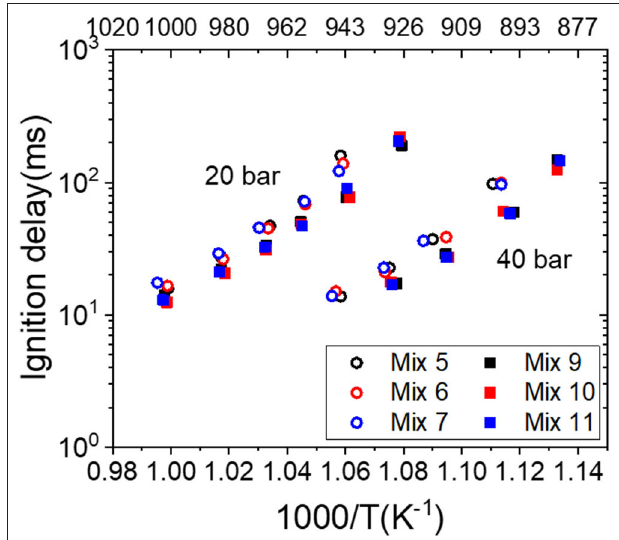
FIGURE 7 | Ignition delay times (IDTs) of the liquefied natural gas (LNG)/liquefied biogas (LBG) mixtures (MN 70 and 74) measured in the rapid compression machine (RCM) at 20 and 40 bar, φ =